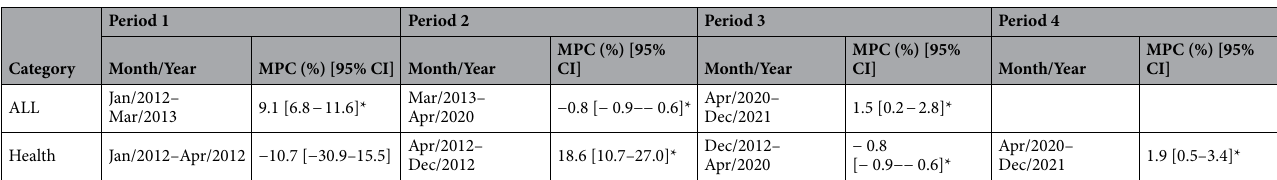
Table 1. Monthly percentage changes (MPC) in relative search volumes (RSV) of “Shikyuu-keigan (cervical cancer)”, all through 2012 to 2021. SE, standard error; CI, confidence interval. *Significantly different from zero ( p <